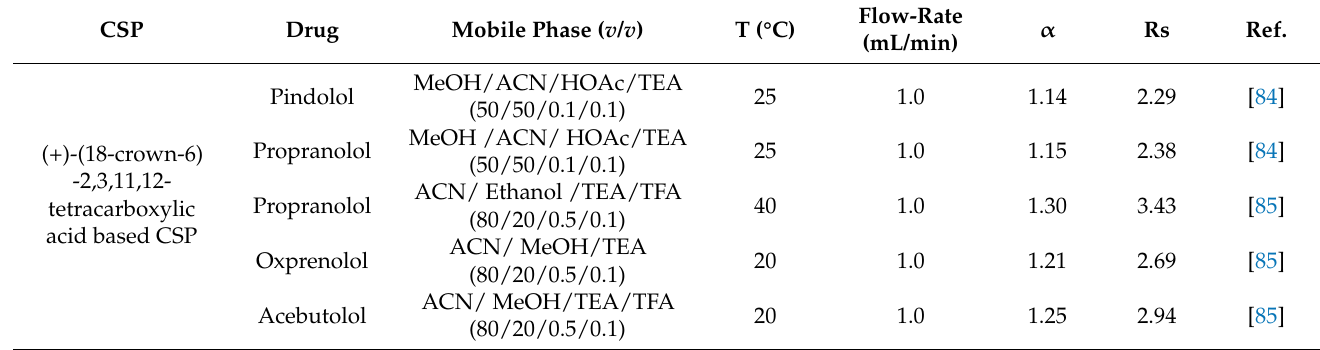
Table 7. Typical results for the enantioseparation of β -blockers on the (+)-(18-crown-6)-2,3,11,12-tetracarboxylic acid based CSP. CSP